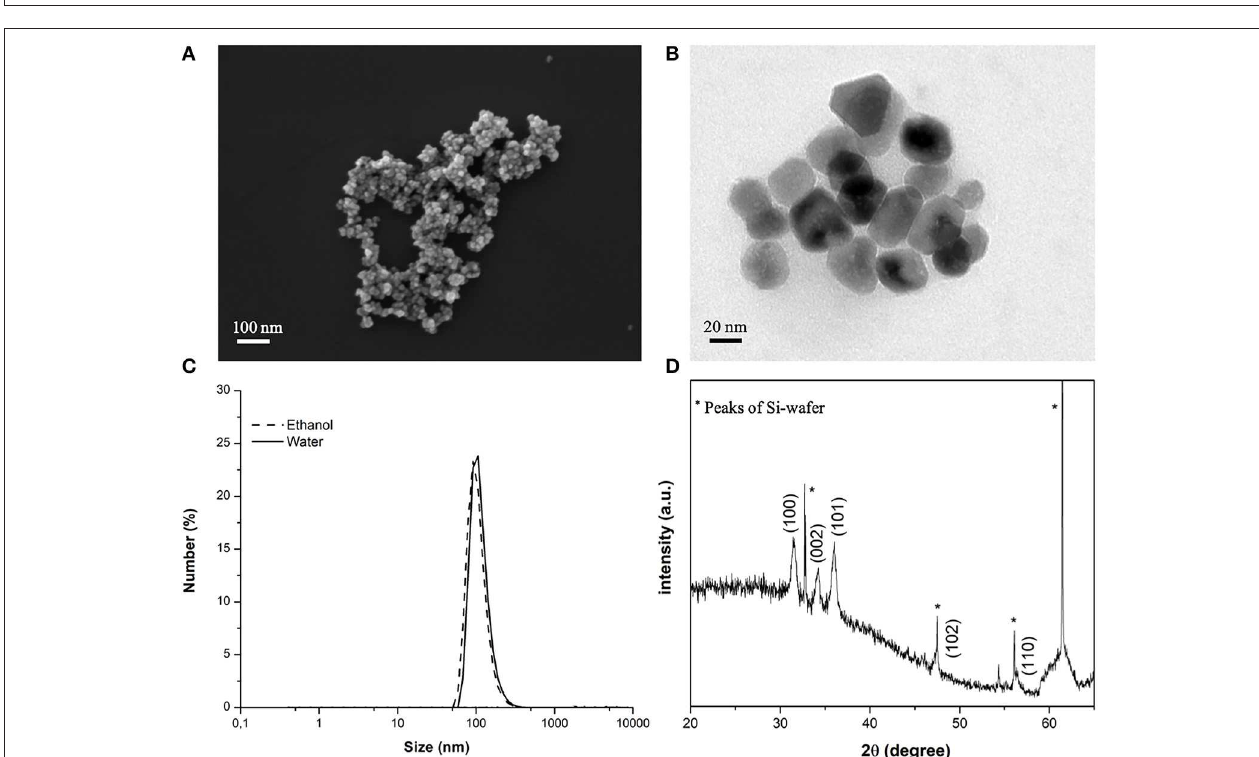
FIGURE 2 | (A) FESEM and (B) TEM images of the ZnO-NH 2 NCs used in this study; (C) average hydrodynamic diameter in ethanolic solution by DLS and (D) XRD pattern of the